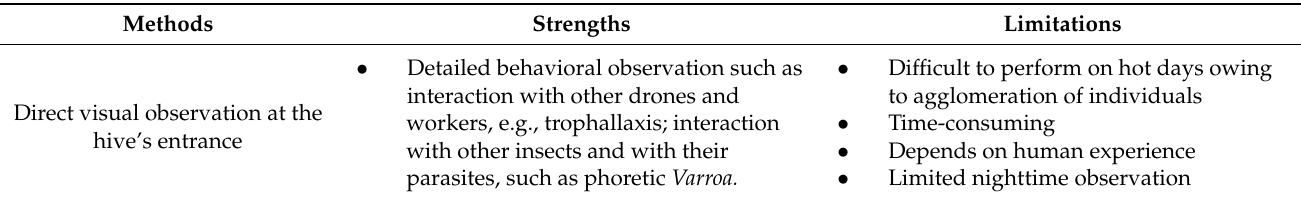
Table 2. Comparison of the strengths and limitations of the three methods used in this research: direct visual observation, indirect visual observation, and electronic tagging (RFID). Methods